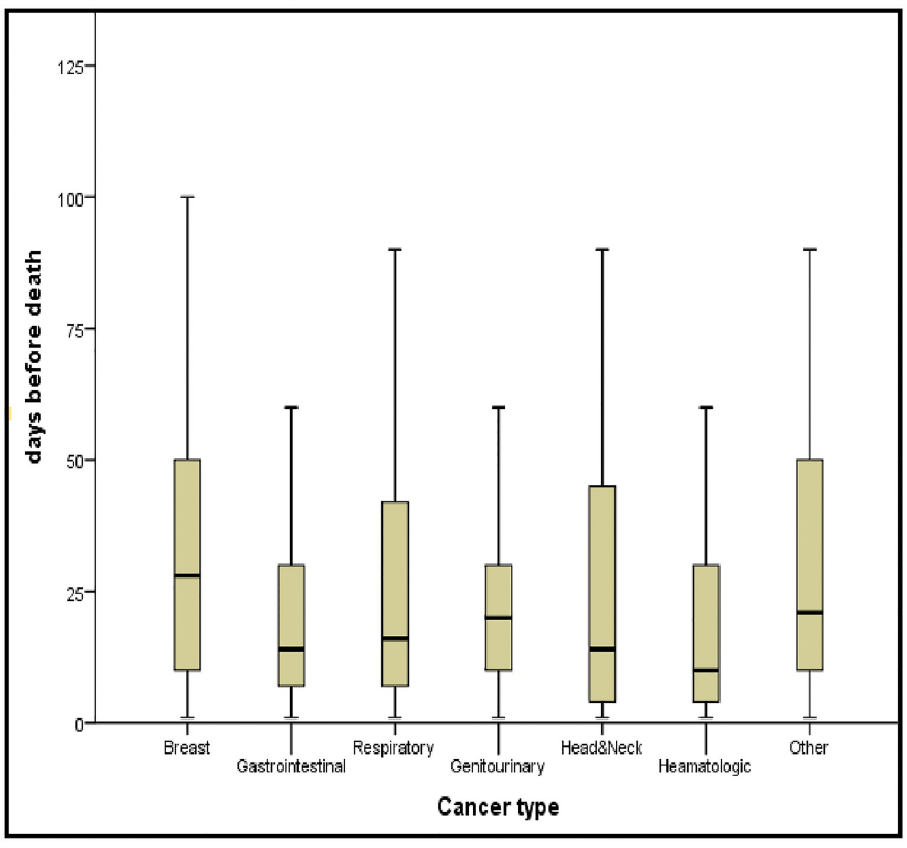
Fig 1. Box plot of timing of referral to palliative care services (days before death) per cancer type. Outliers are not shown and differ per cancer type: Breast: > 114 days (n = 7); Gastrointestinal: > 64 days (n = 26); Respiratory: > 107 days (n = 11); Genitourinary: > 60 days (n = 14); Head &Neck: > 107 days (n = 1); Hematologic: > 65 days (n = 5); Other: > 105 (n = 5).